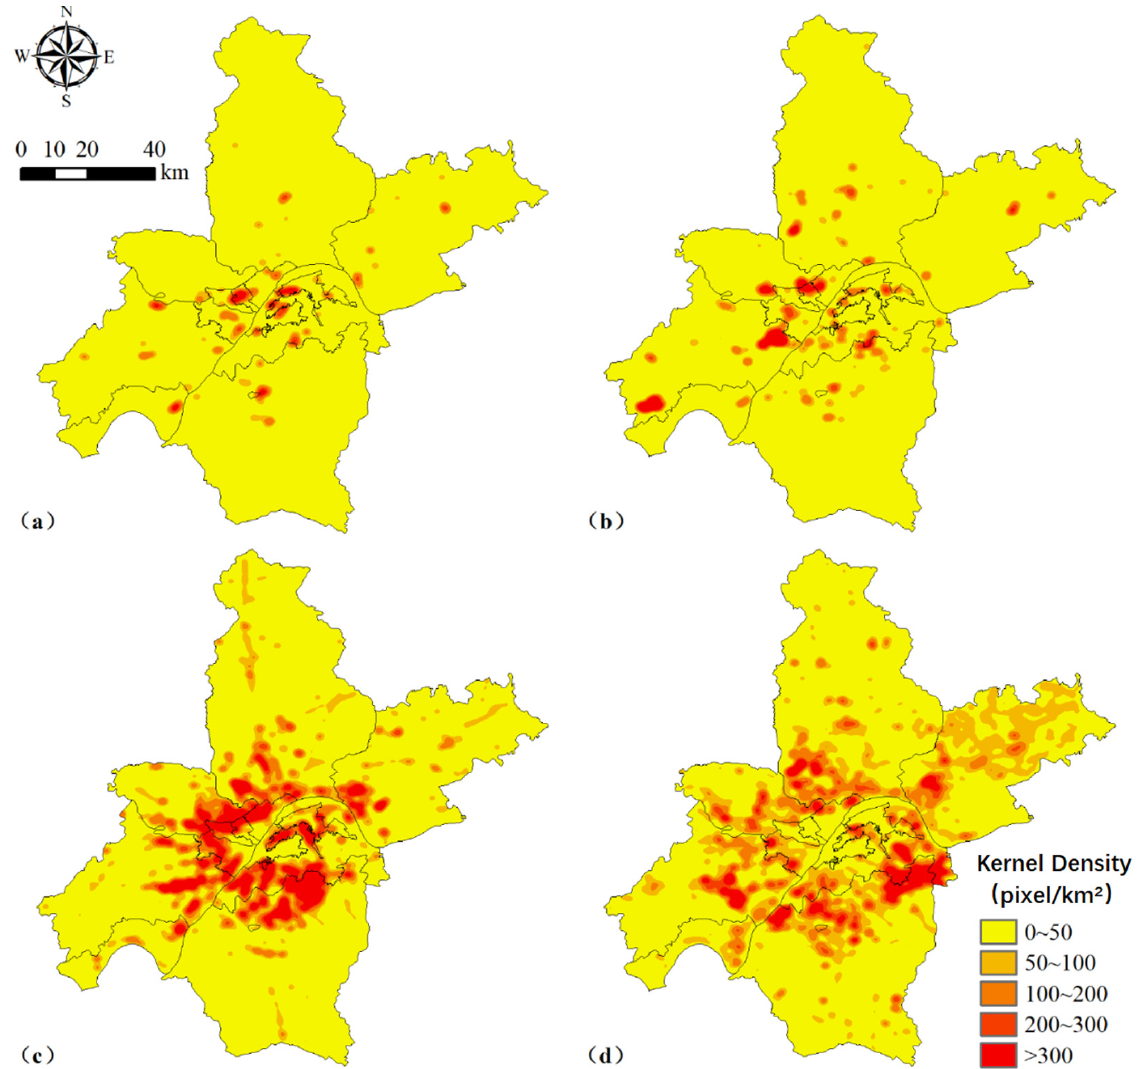
Figure 3. Kernel density of urban expansion during 1980–1990 ( a ), 1990–2000 ( b ), 2000–2010 ( c ), and 2010–2020 ( d ) in Wuhan city, China. Each pixel represents 30 m × 30 m.